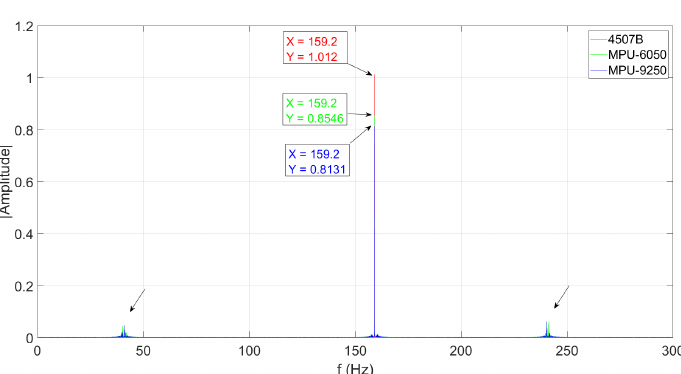
Figure 7. Responses in the frequency domain using the universal calibrator at 159,2 Hz/1,0g.